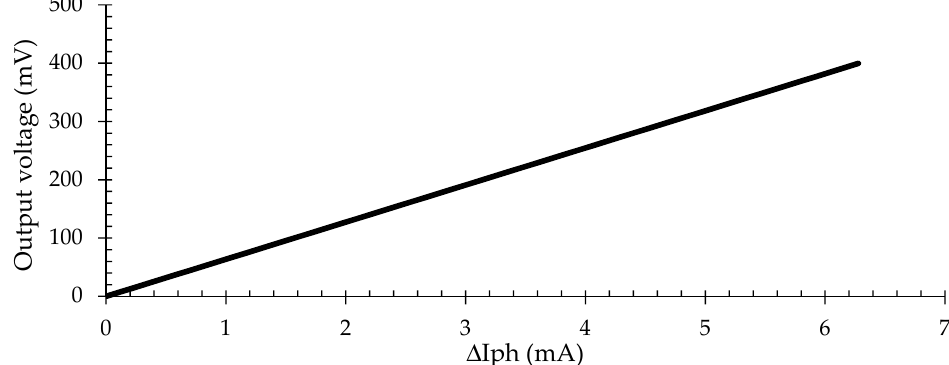
Figure 5. Output voltage (mV) behavior for the signal conditioning circuit. Figure 4. Architecture of the signal conditioning circuit.